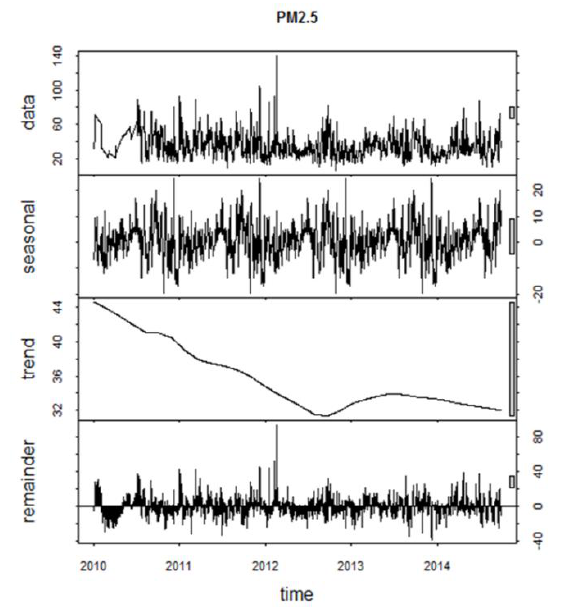
Figure 4. Tehran mortality timescale decomposition among individuals of less than